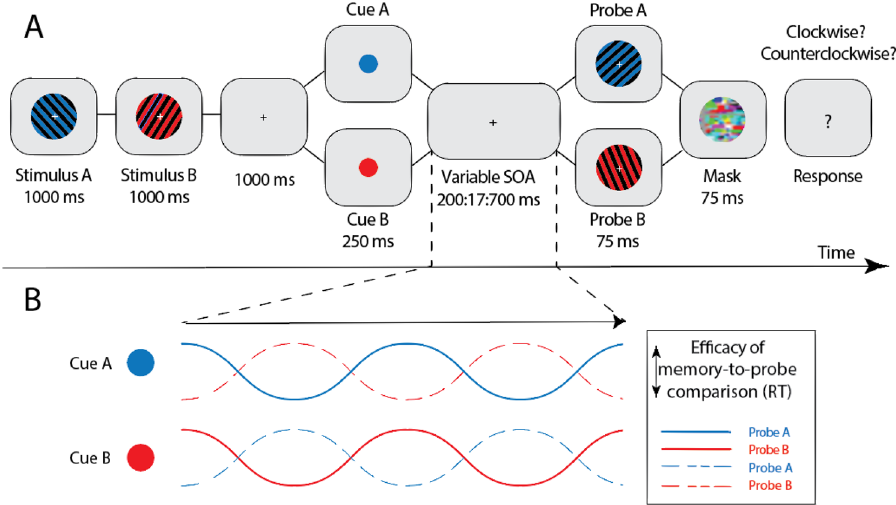
Figure 1. ( A ) Task paradigm. Participants encoded two gratings with different colors and orientations. A subsequent retro-cue, indicative of the probe color (75% validity), was presented to reset attention to one of the items in working memory. We measured behavior at several densely sampled timepoints (between 200 and 700 ms) by presenting the probe and asking participants if it was rotated clockwise or counterclockwise relative to the same-colored item in working memory. ( B ) Expected temporal dynamics of object-based attention in working memory for different cue